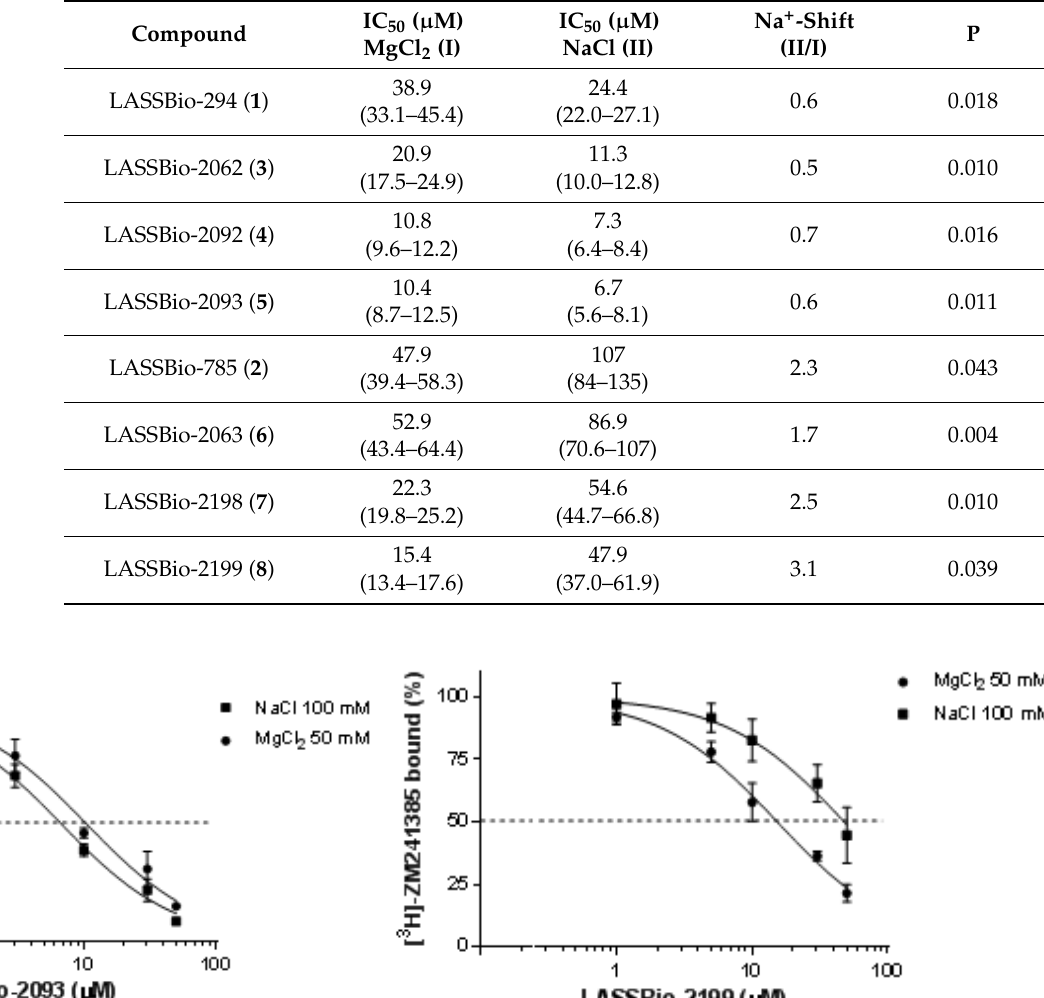
Table 2. Affinity and intrinsic efficacy of the N -acylhydrazone derivatives at the A 2A receptor (A 2A R) present in membrane preparations from rat striatum. Average curves of three-four independent experiments (in triplicate) were analyzed by non-linear regression to estimate the IC 50 values with their 95% confidence interval (95% CI). For each compound, the Na + -shifts were calculated by dividing the IC 50 value obtained in the medium containing NaCl (II) by the IC 50 value obtained in the medium containing MgCl 2 (I) and statistically analyzed by paired t test on log IC 50 values (P). Na + -shifts lower than one indicates that compounds 1 and 3 – 5 are weak inverse agonists, whereas Na + -shifts higher indicate that N -methylated compounds 2 and 6 – 8 are weak partial agonists.